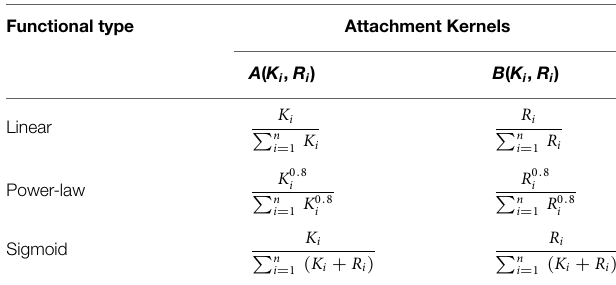
TABLE 1 | Attachment kernels used here to “grow” networks (Mayo et al., 2012)